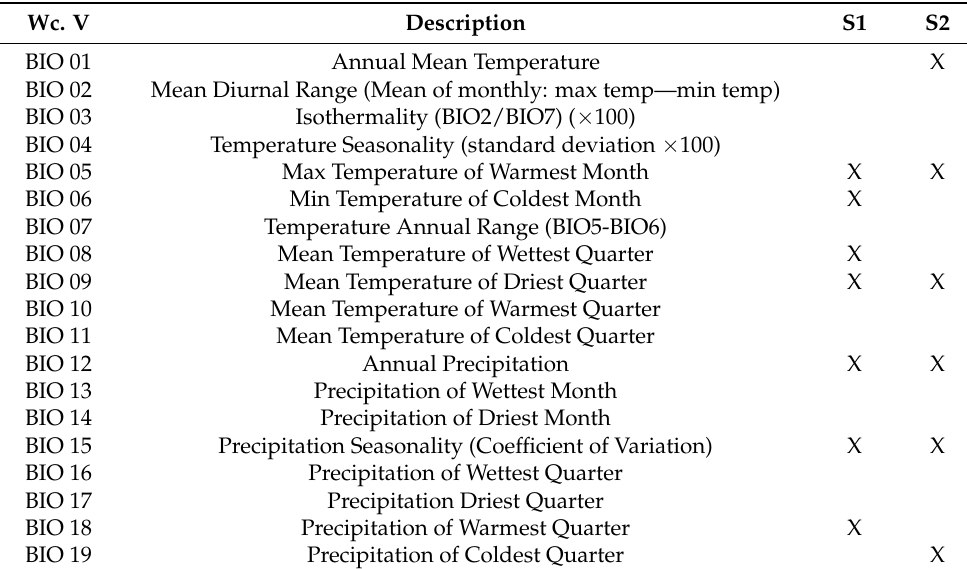
Table 2. Wc. V: WorldClim v1.4 climatic variables and their descriptions [51,70]. S1, S2: The two climatic variable sets used to calibrate the